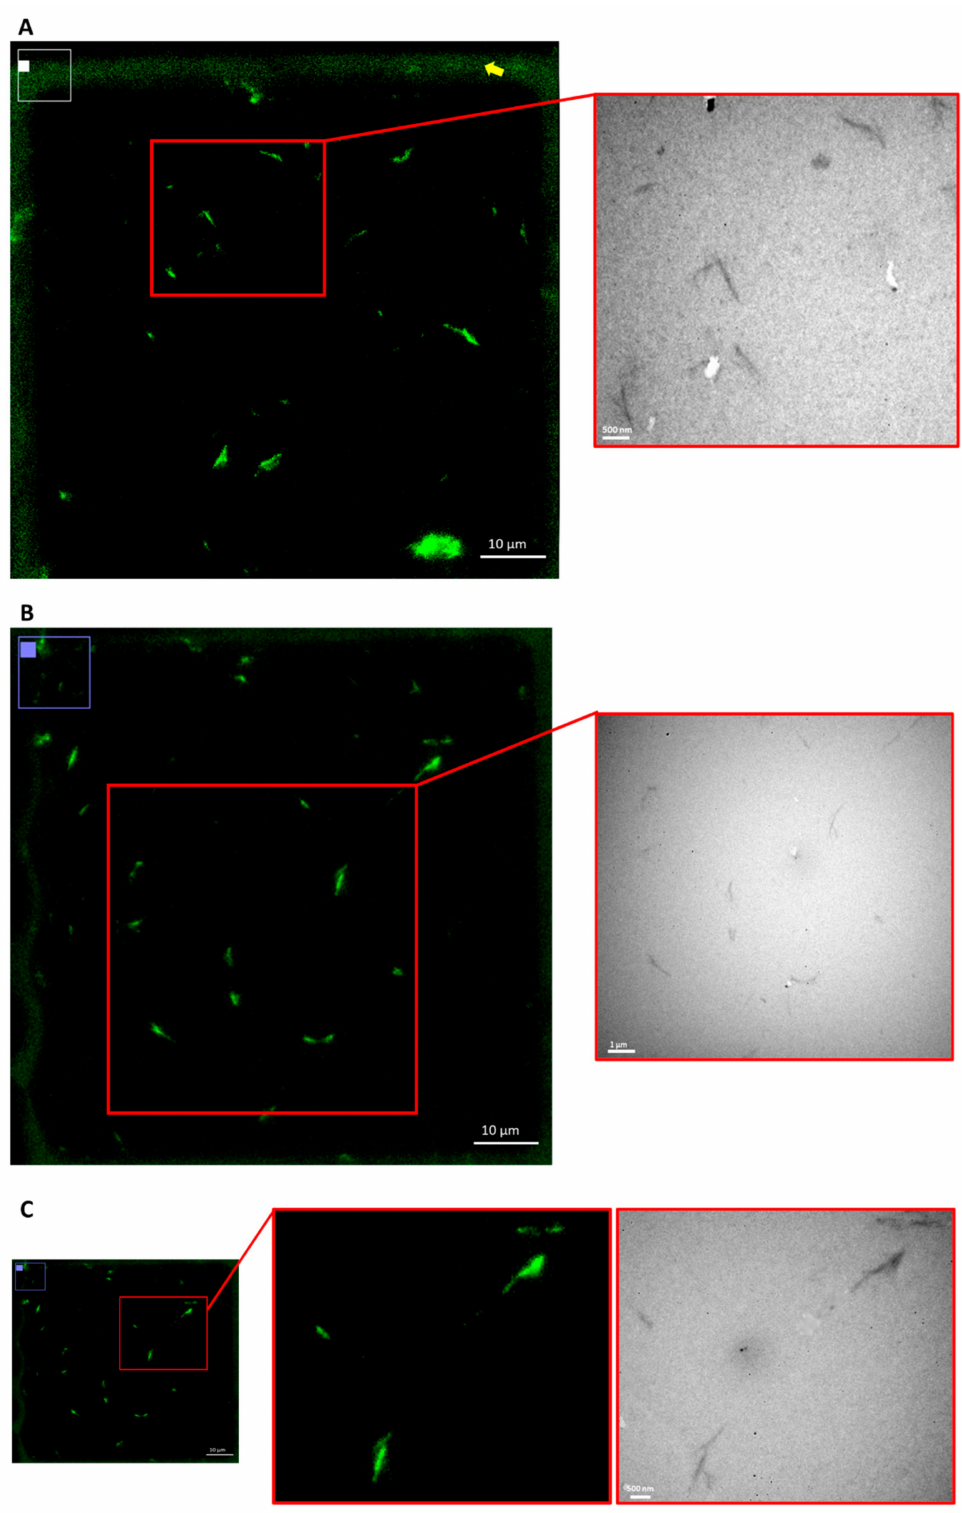
Figure 6. CLEM images of BCNC labeled with GFP–CBM. Small green dots in FM correspond to single BCNC in TEM (highlighted in the red boxes). The solid part of the TEM grid had some autofluorescence (yellow arrow); however, it did not interfere with the visualization as the GFP– CBM:BCNC-gelatin mixture was fixed in the transparent network mesh. Scale bars: ( A – C ) 10 µ m for FM, ( A , C ) 500 nm and ( B ) 1 µ m for